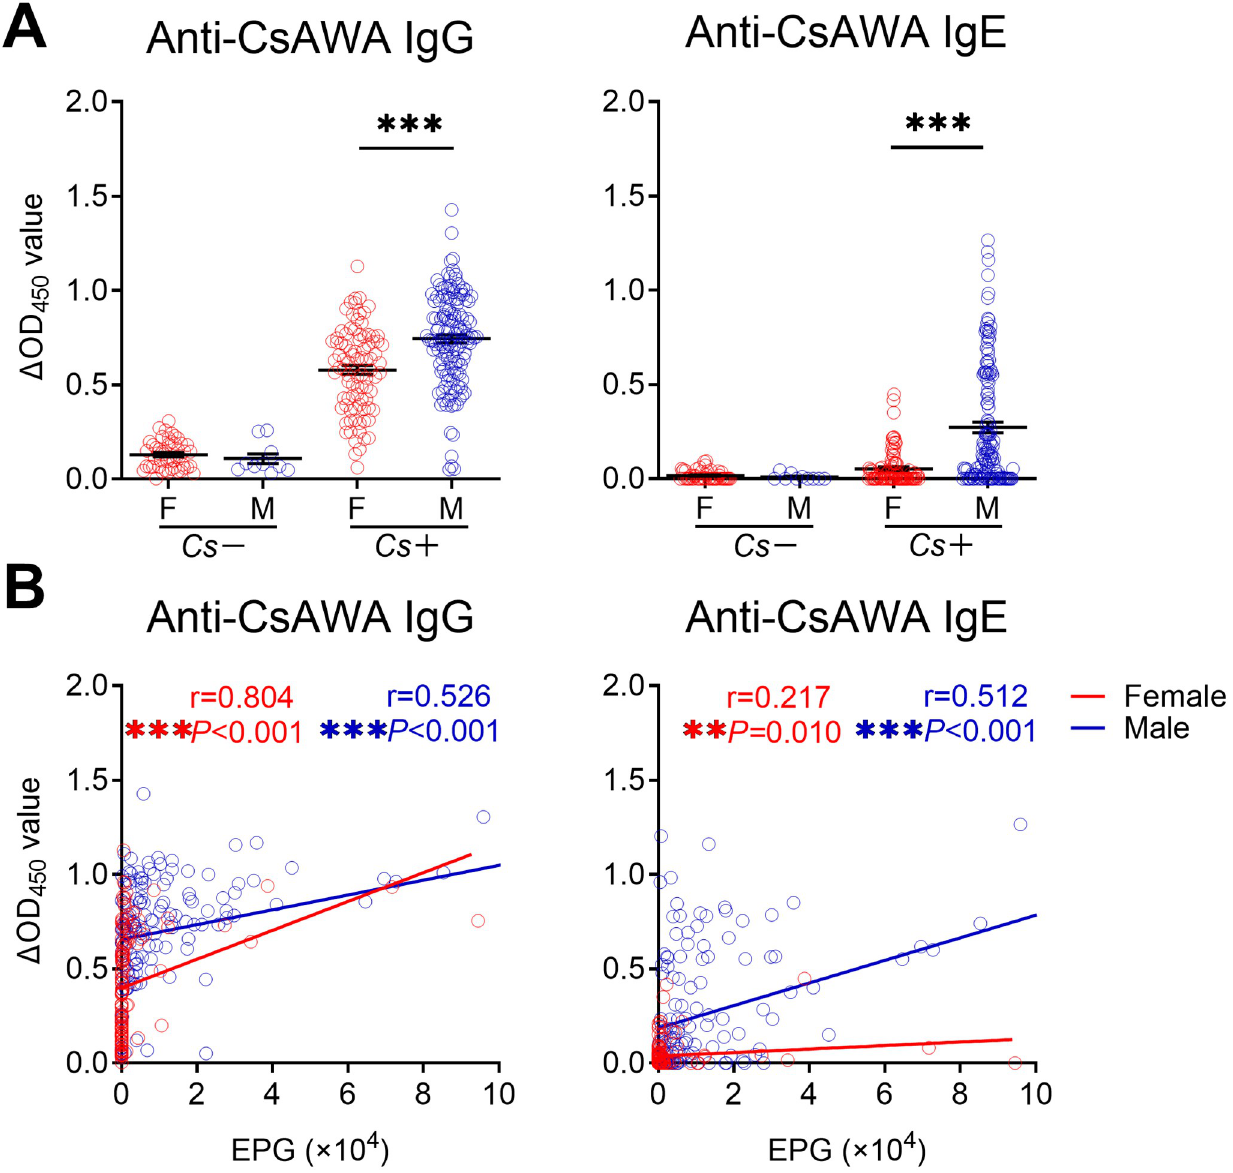
Fig 2. Serum levels of anti-CsAWA IgG and IgE in Cs - and Cs + individuals with different genders. (A) Serum levels of anti-CsAWA IgG and IgE in Cs - individuals (n = 50 in female and n = 10 in male) and Cs + individuals (n = 91 in female and n = 138 in male). (B) Spearman’s correlation analysis between EPG and serum levels of anti-CsAWA IgG and IgE (n = 141 in female and n = 148 in male). CsAWA: C . sinensis adult worm antigen, Cs : C . sinensis infection, F: female, M: male, EPG: eggs per gram of feces. The data were shown as the mean ± s.e.m., �� P < 0.01, ��� P < 0.001, Kruskal-Wallis test followed by Dunn’s multiple comparisons test in (A) , Spearman’s correlation test in (B)